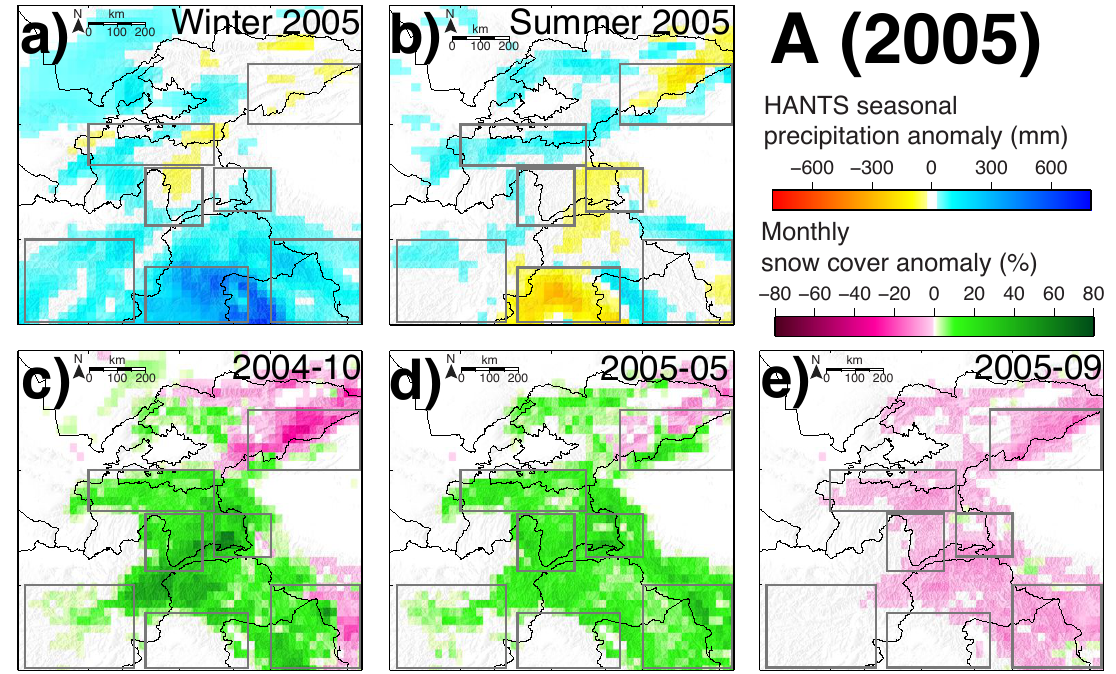
Figure 7. 2005 HANTS precipitation pattern for ( a ) winter and ( b ) summer. Very early snow cover in ( c ) October 2004 lasted till the end of ( d ) spring 2005 before diminution of snow cover to normal values occurred (see Figure 6), leading to slightly negative anomalies in ( e ) September